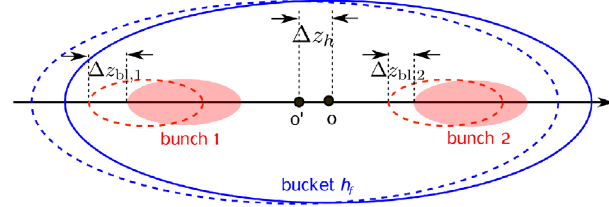
FIG. 8. Schematic drawing of the shifts Δ z , Δ z on the two bl ; 1 bl ; 2 bunches for beam-loading matching and the shift Δ z on the h harmonics for symmetry compensation: The red shade areas represent the bunches without beam-loading-matching shift; the red dashed ellipses indicate the shifted bunches with beam- loading matching; the solid blue line denotes the bucket on the final harmonic h with its center o ; the dashed blue ellipse is the f shifted bucket with its center o 0 to keep the symmetry of the two bunches during bunch acting bl